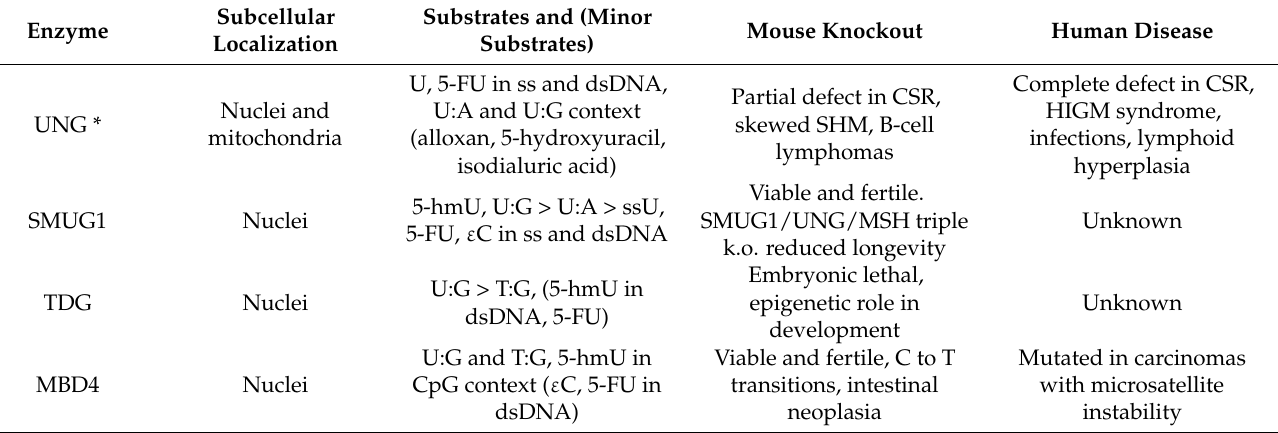
Table 1. Mammalian uracil-DNA